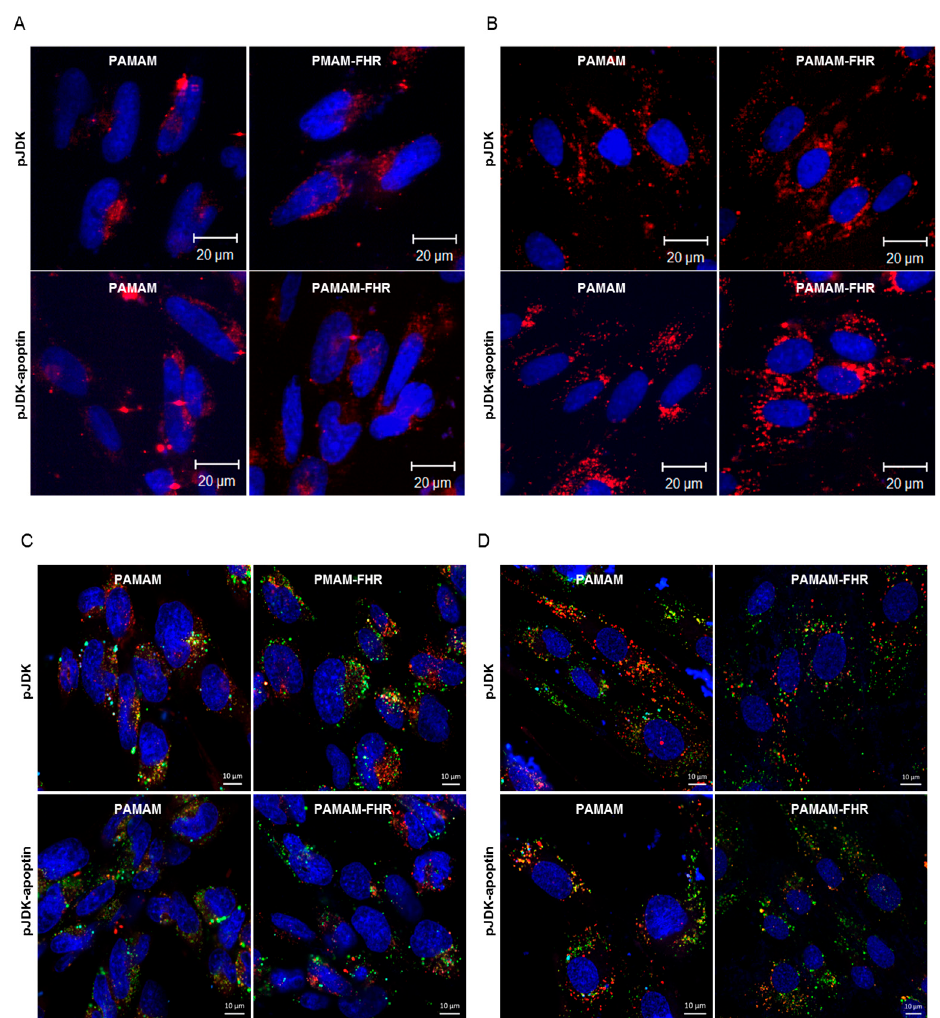
Figure 6 . Intracellular localization of PAMAM-FHR. ( A ) GBL-14 and ( B ) dermal fibroblasts were incubated with polymer/Alexa Fluor 546 labeled pJDK or pJDK-apoptin complexes for 24 h. Nuclei were stained before confocal microscopy. ( C ) GBL-14 and ( D ) dermal fibroblasts were incubated with Alexa Fluor 488-labeled each polymer/pJDK or pJDK-apoptin complexes for 24 h. Lysosomal images were incubated with LysoTracker Red for 15 min before confocal microscopy .